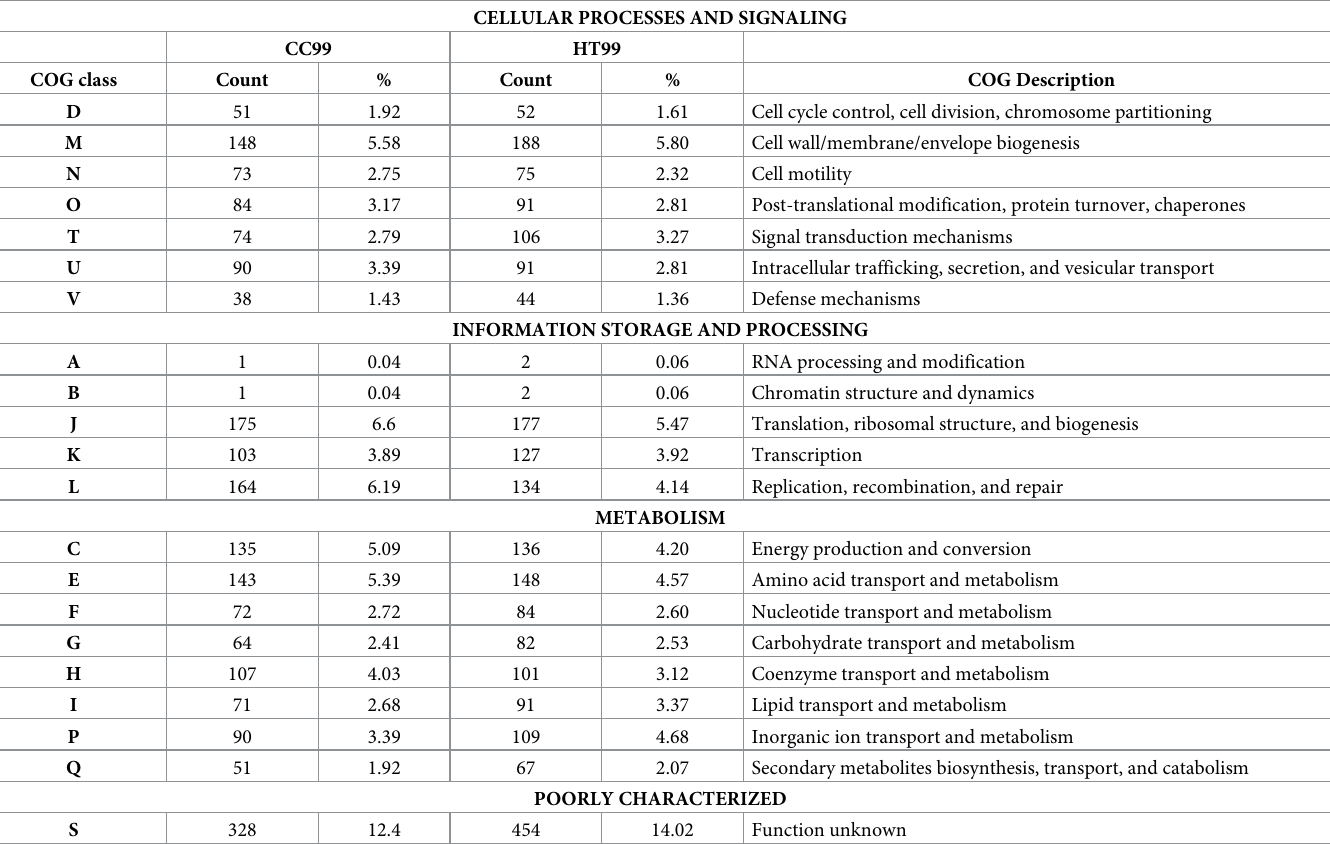
Table 2. “ Ca . B. cookevillensis” (CC99) and “ Ca . B. aquae” (HT99) PEGs grouped into COG functional categories. CELLULAR PROCESSES AND